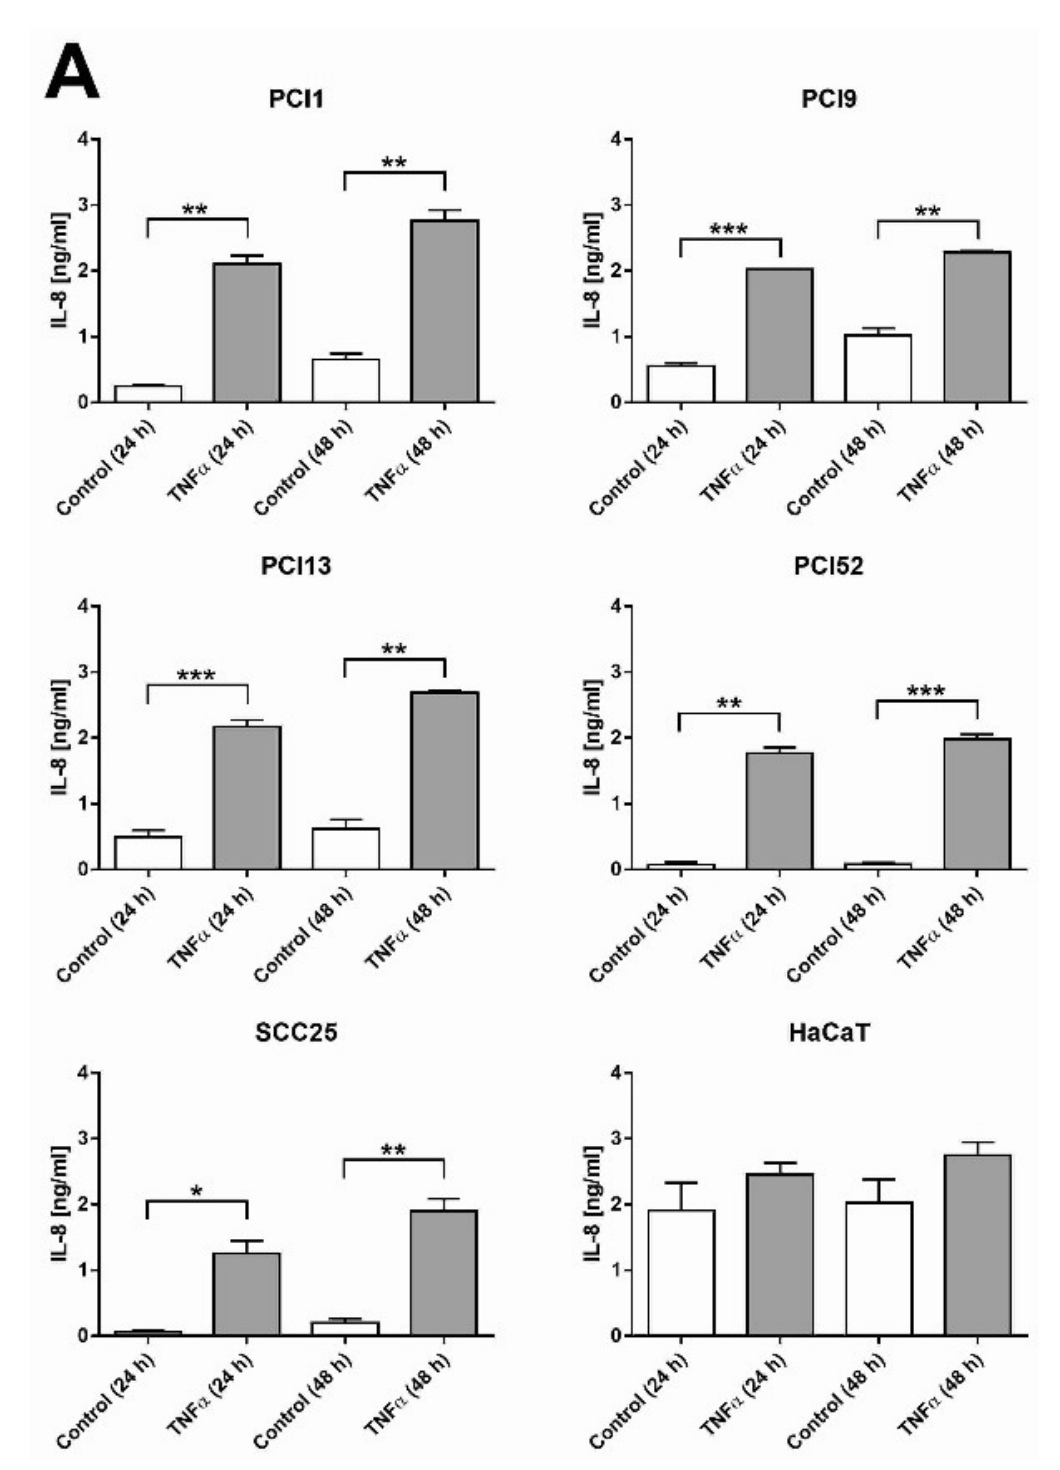
Figure 1. Cont Figure 1. Cont.